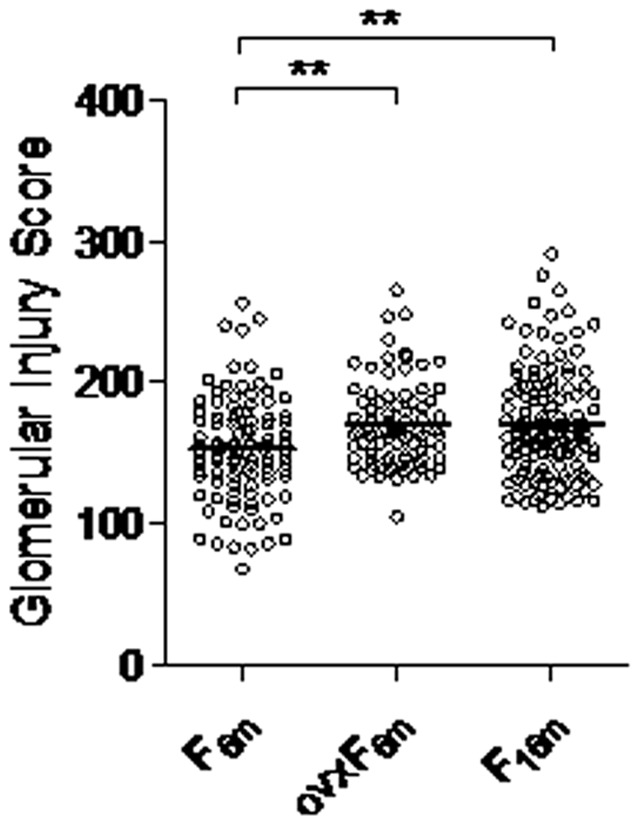
Distribution of GIS in premenopausal, ovariectomized and postmenopausal F2 (Dahl S x R)-intercross cohorts.Distribution of GIS in premenopausal F2 (F6m, n = 102) female hybrids at 6 months of age (8% NaCl challenge begun at 3 months of age); ovariectomized female F2 (ovxF6m, n = 116) hybrids at 6 months of age (8% NaCl challenge begun at 3 months of age) and postmenopausal F2 (F16m, n = 130) female hybrids at 16 months of age (8% NaCl challenge begun at 14 months of age). Means are shown as horizontal lines. **
P<0.01 (one-way ANOVA followed by Holm-Sidak test for multiple comparisons).